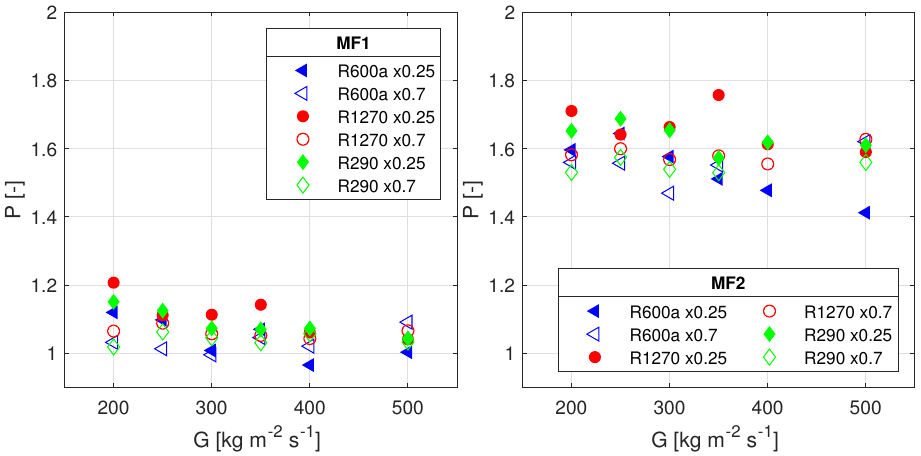
Figure 11. Effect of mass flux on penalization factor, P , for MF tubes at x = 0.25 and x =